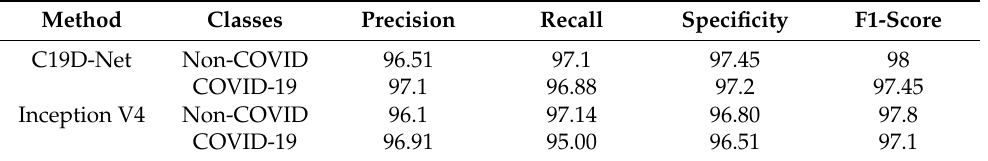
Table 7. Performance comparison of 2-class C19D-Net, InceptionV4.